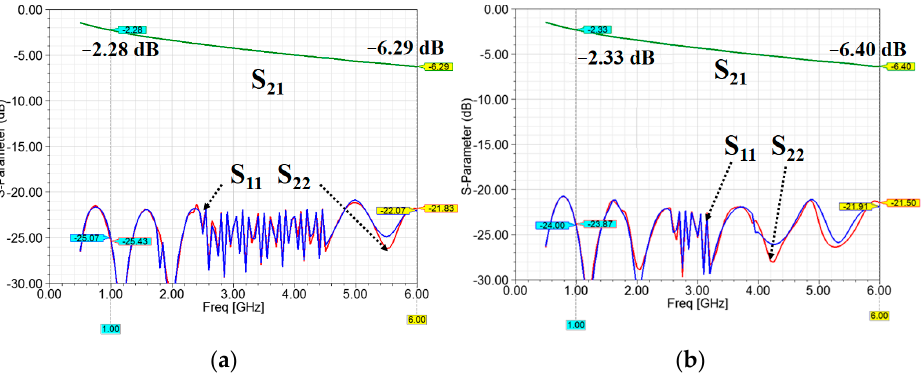
Figure 12. Simulated insertion loss and return loss of ( a ) parallel ground lines, and ( b ) asymmetric via placement.